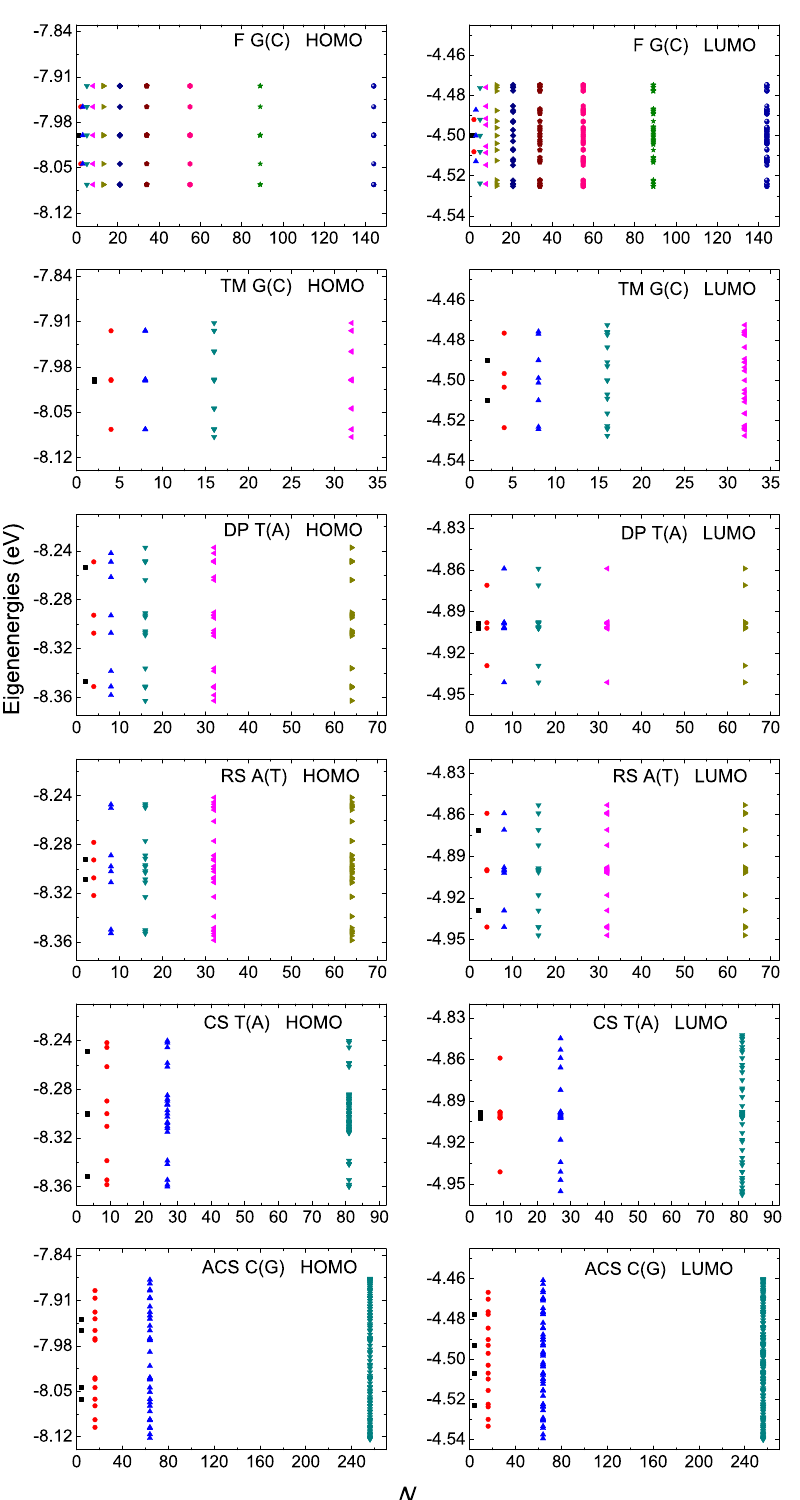
Figure 1. Eigenspectra of F G(C), TM G(C), DP T(A), RS A(T), CS T(A), ACS C(G) polymers, for the HOMO (left column) regime and the LUMO (right column) regime, for a few generations. The horizontal axis shows the number of monomers in the polymer N . Different colors correspond to different generations. The notation of polymers is given in Table